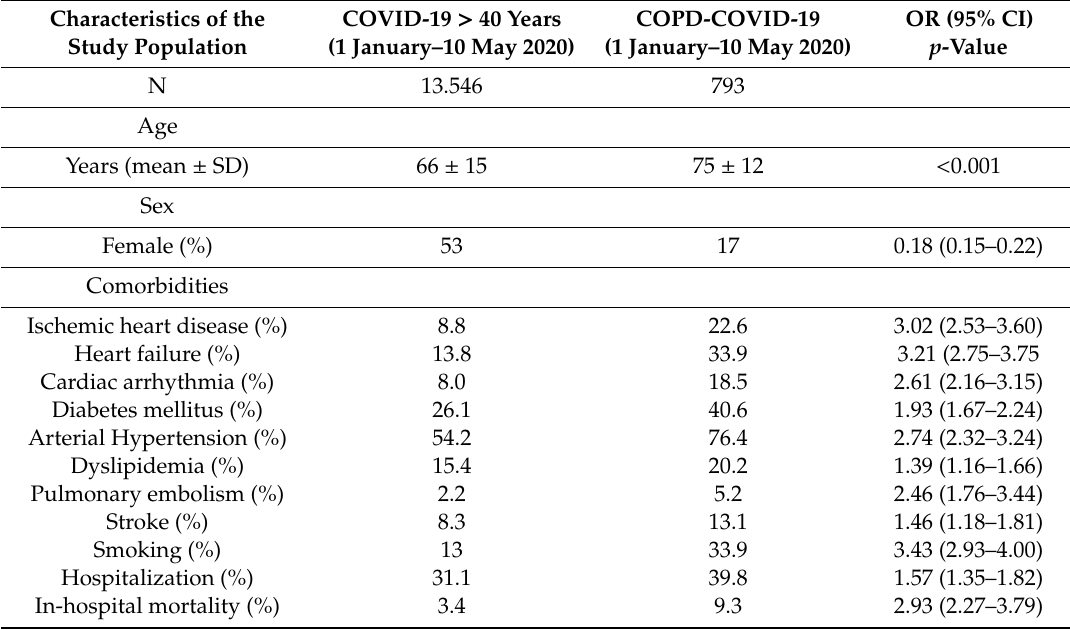
Table 1. Characteristics and clinical outcomes of the study population.